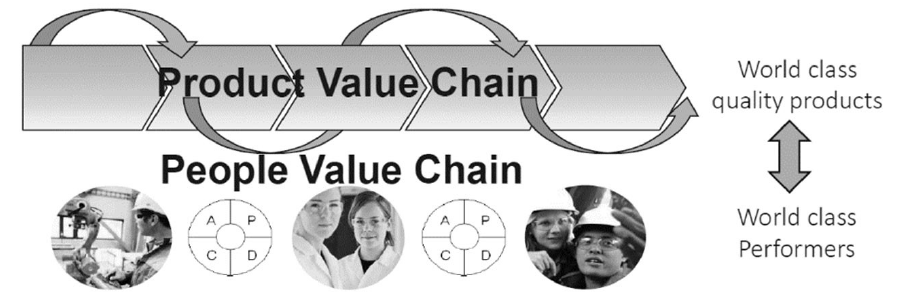
Figure 1. The double integrated chain of value (from a company